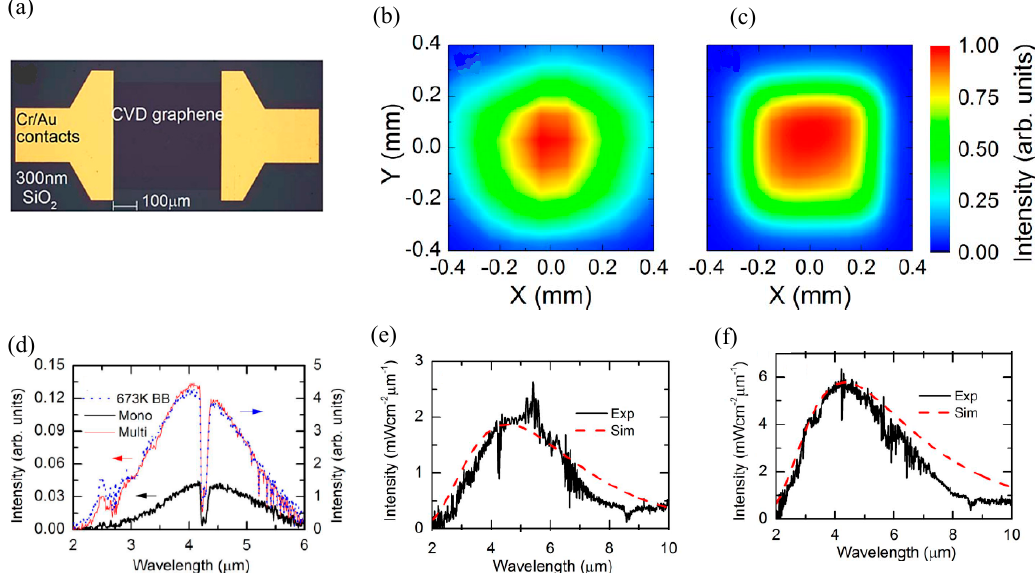
Figure 3. ( a ) The device fabricated with large area graphene 0.5 × 0.6 mm, transferred on 300 nm SiO 2 substrate, with CR / Ar source and drain contacts. ( b , c ) shows the thermal emission from single and multi-layered graphene, ( b ) emission from single-layer graphene with peak current injection of 44 mA, ( c ) emission from multi-layer graphene with peak current injection of 52 mA. ( d ) The emission spectra of single and multi-layered graphene, calibrated with the back body at 673 K, where the peak emission was approximately 4 um and the large deep trench at 4.2 µ m was ascribed to the CO 2 absorption. ( e , f ) shows the measured and simulated spectra with a dash [21].